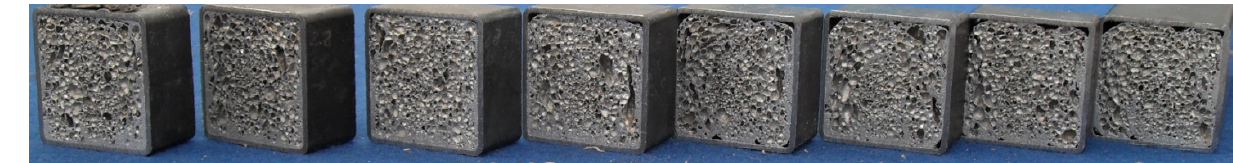
Figure 2. Aluminum foam filled tube cross